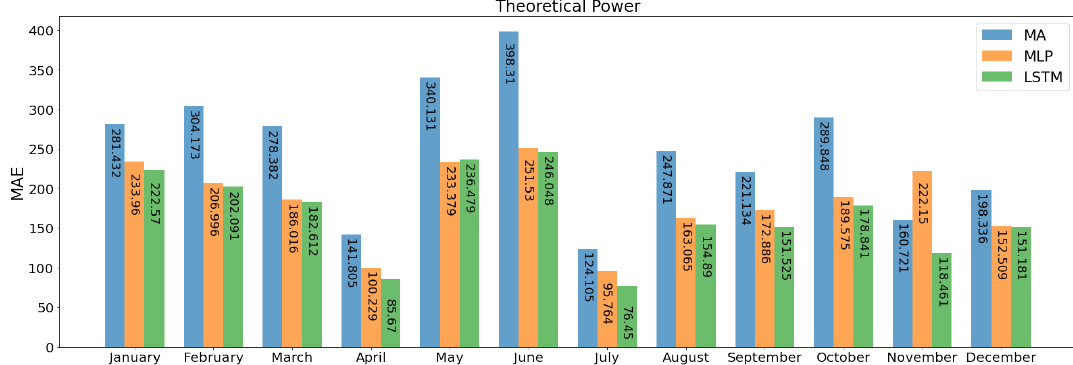
Figure 25. The performance metric (MAE) comparison for theoretical power prediction for whole